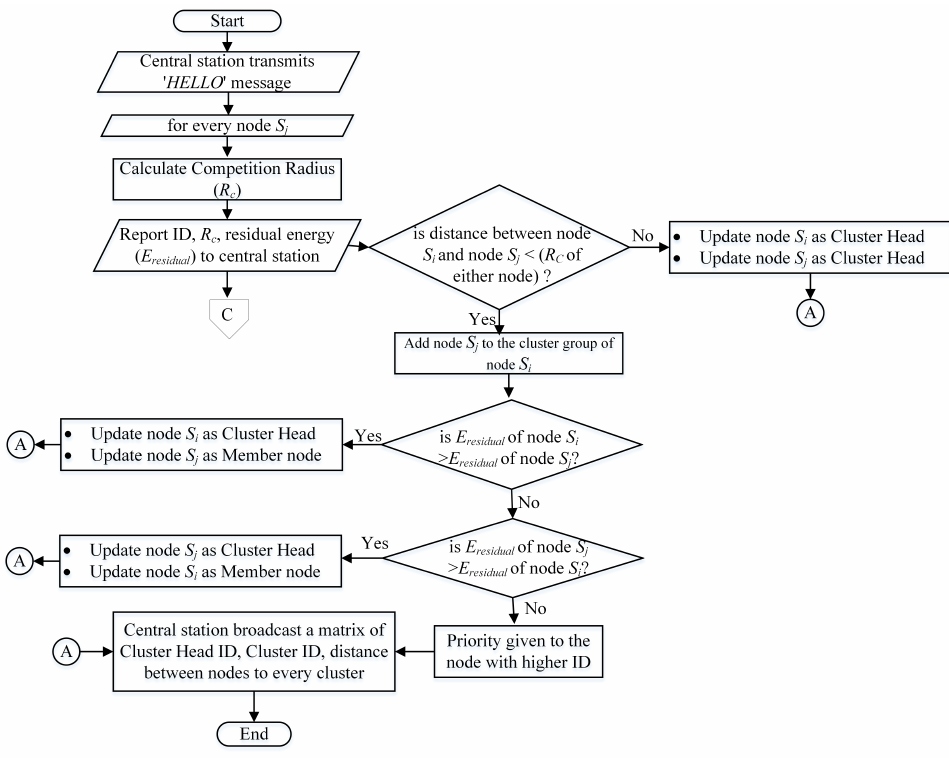
Figure 2. Selection of Cluster